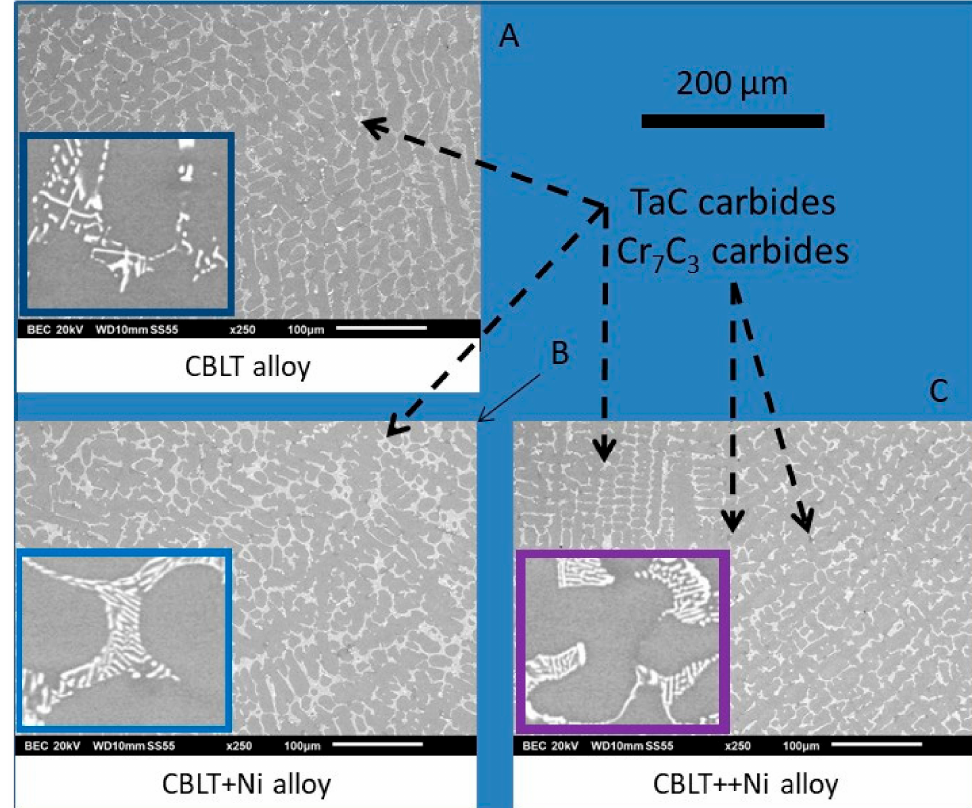
Figure 1. SEM/BSE microstructures of the three alloys in their as-cast states (large micrographs × 250; inserted micrographs × 2000): ( A ): the CBLT alloy; ( B ): the CBLT+Ni alloy; ( C ): the CBLT++Ni